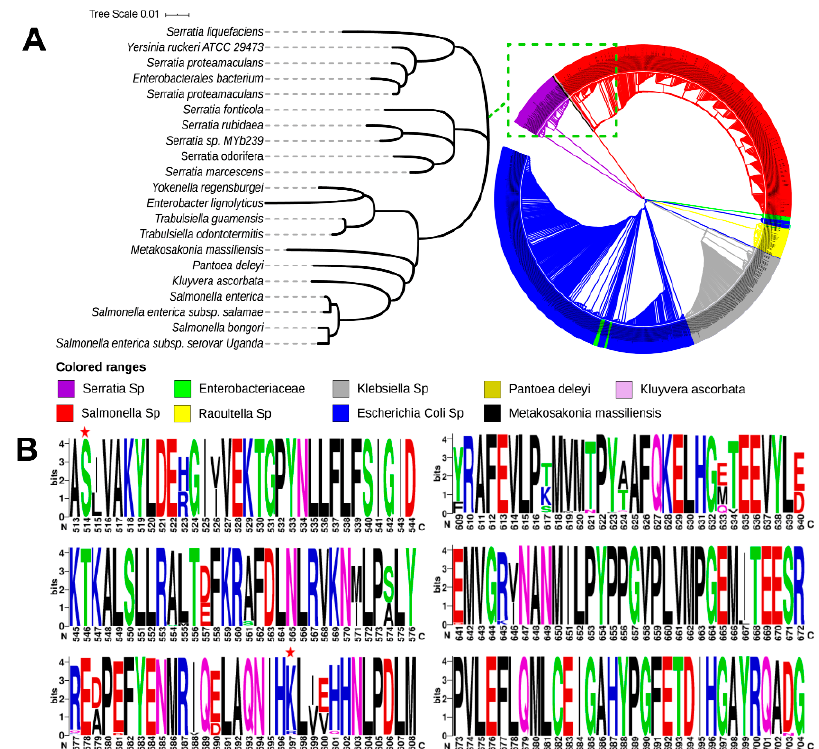
Figure 1. Phylogeny and amino acid residue conservation profiling. ( A ). Phylogenetic tree of the 1000 protein homologues of SmcadA ( B ). Profiling of amino acid residues for conservation using WebLogo. The large, long and wide letter codes represent highly conserved residues.